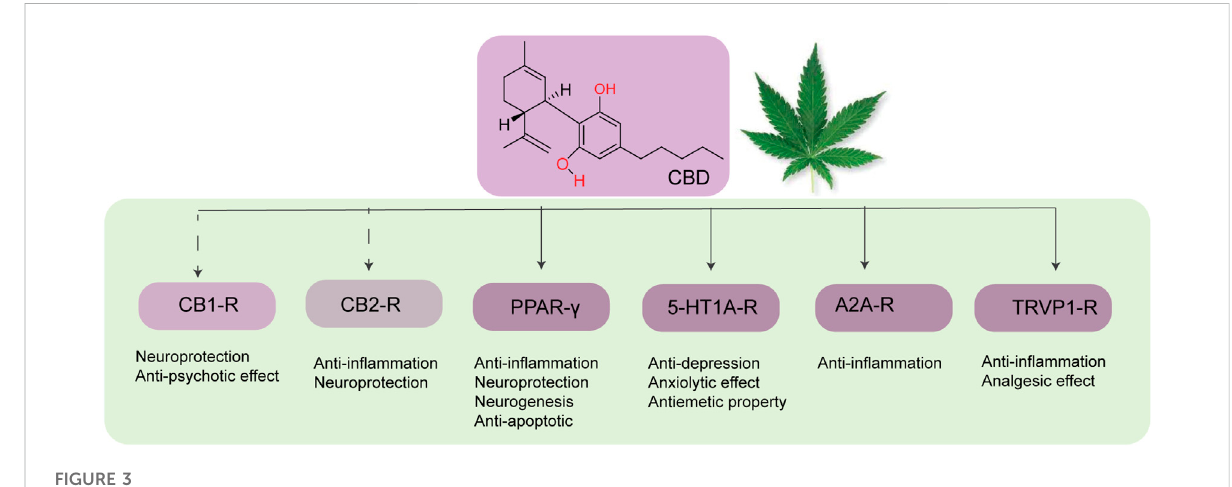
FIGURE 3 Different molecular targets of CBD in the brain.